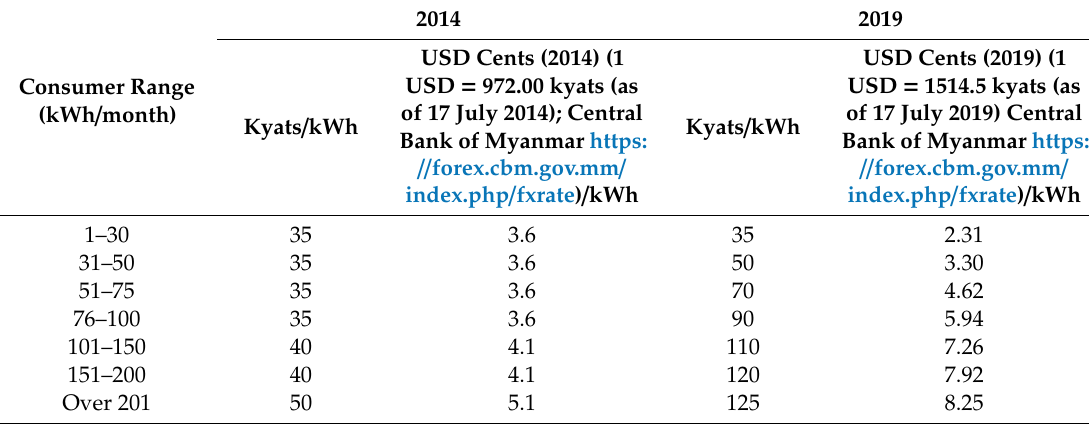
Table 2. Rates for electrical power consumption for domestic (domestic consumption, power meter at homes, religious building) consumers in 2014 and after the tari ff hike in 2019.